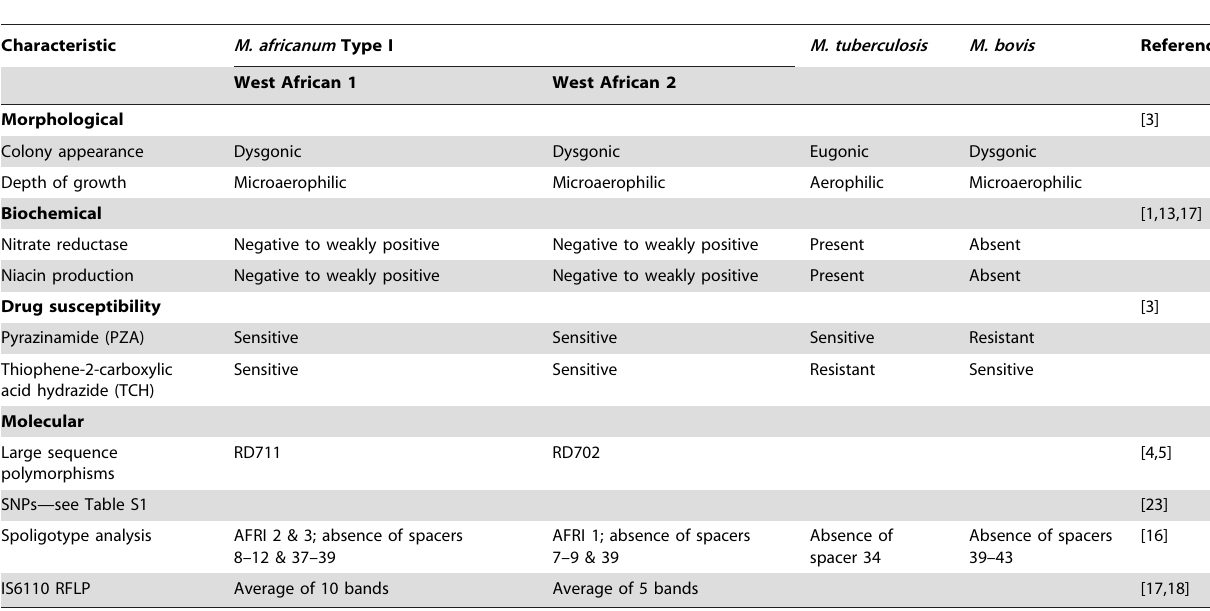
Table 1. Classification of M. africanum Relative to M. tuberculosis and M. bovis .